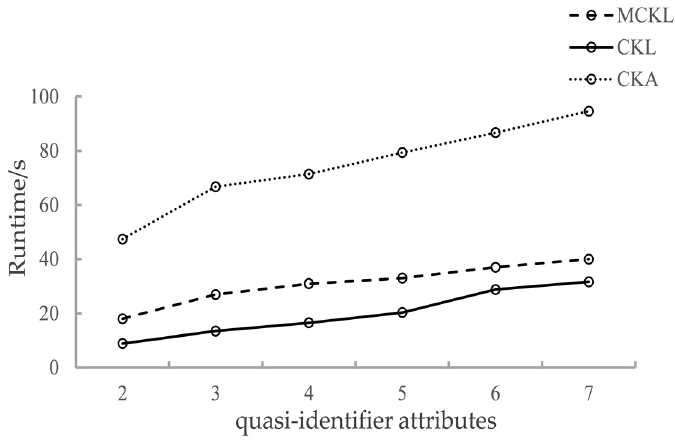
Figure 4. Effect of QI attributes on runtime. Figure 4. E ff ect of QI a tt ributes on runtime.